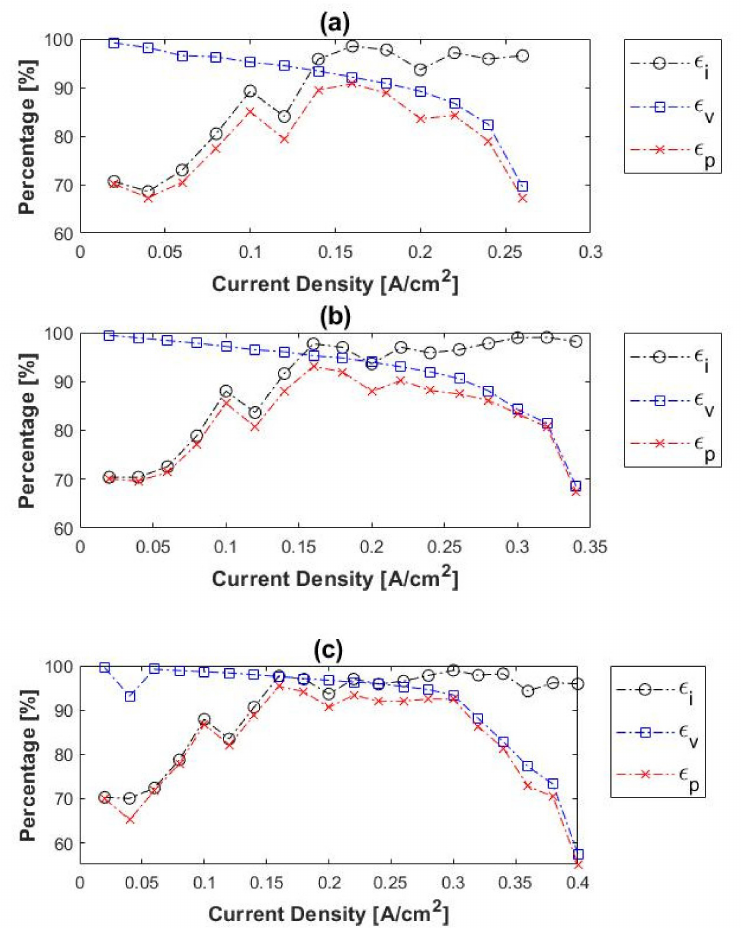
Figure 6. Current-( ε i ), voltage-( ε v ), and power ( ε p ) efficiencies as a function of current density at ( a )